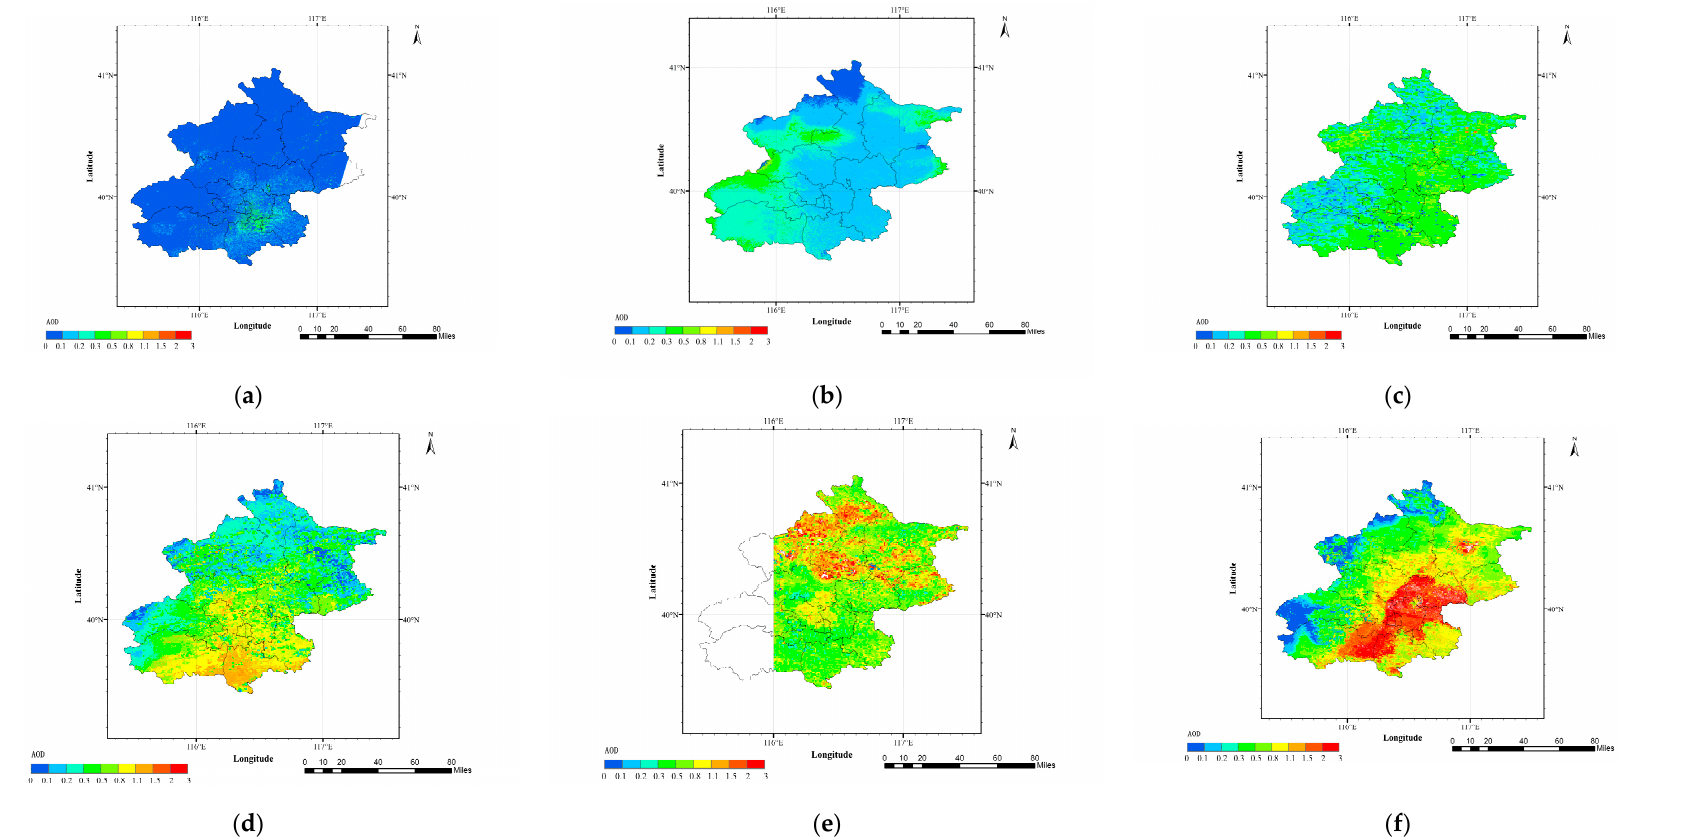
Figure 3. The AOD retrieval results from TERRA/AQUA MODIS data during the sunny days and foggy days: ( a – c ) are the AOD results of sunny days on 19 September, 7 November and 13 January 2020, respectively; ( d – f ) are the AOD results of foggy days on 25 January, 12 January and 11 February 2020, respectively.